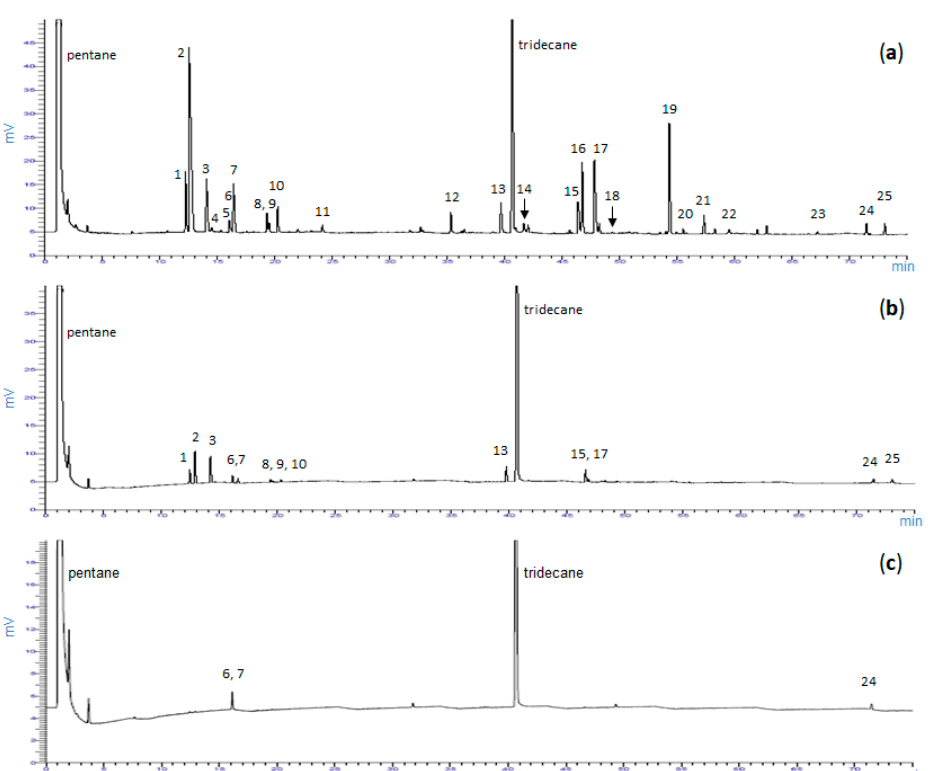
Figure 1. Representative GC-MS chromatogram of foliar ( a ), cortical ( b ) and xylem ( c ) tissues of Rosmarinus officinalis L. showing chiral and non-chiral volatile terpenoids. 1, ( − )- α -pinene; 2, (+)- α -pinene; 3, camphene; 4, sabinene; 5, myrcene; 6, (+)- β -pinene; 7, ( − )- β -pinene; 8, ( − )-limonene; 9, (+)-limonene; 10, p-cymene; 11, 1,8-cineole; 12, ( − )-linalool; 13, camphor; 14, terpinen-4-ol; 15, borneol; 16, ( − )-bornylacetate; 17, ( − )-verbenone; 18, geraniol; 19, β -caryophyllene; 20, geranyl acetate; 21, α -humulene; 22, eugenol; 23, thymol; 24, carvacrol; 25, caryophyllene oxide. Tridecane as internal standard. Metabolite identification obtained by both mass spectrum and retention time index.